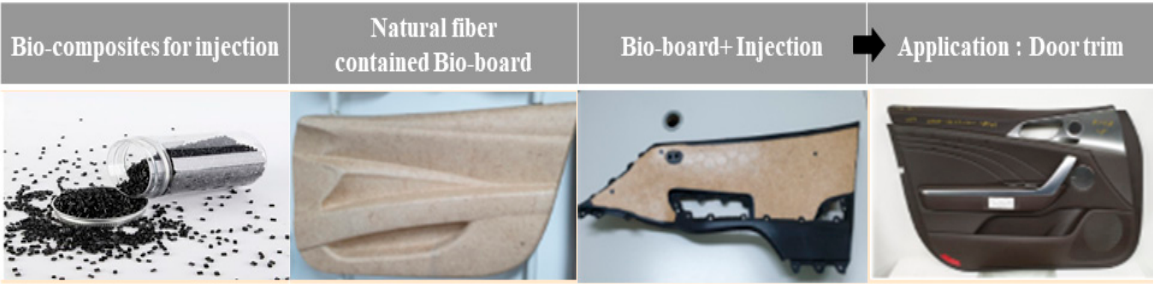
Figure 6. Application to biocomposite materials and automobile interior materials.